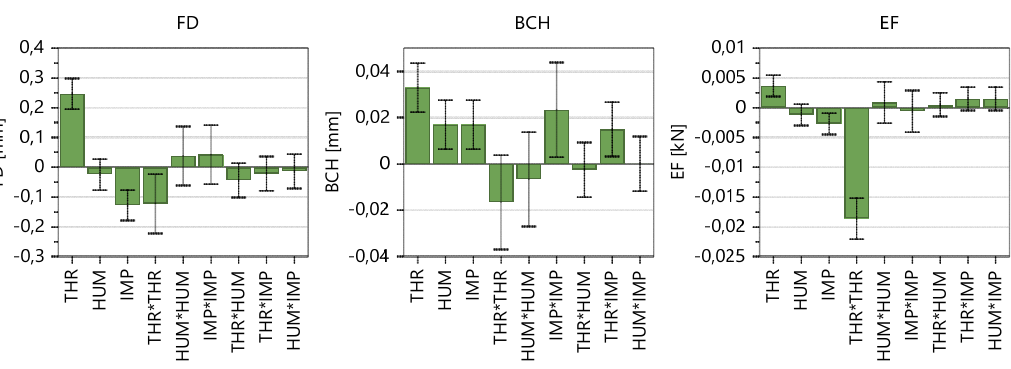
Figure 7. Coefficients plot of model terms regarding tablet press parameters. The 95% confidence interval is displayed as an error bar.